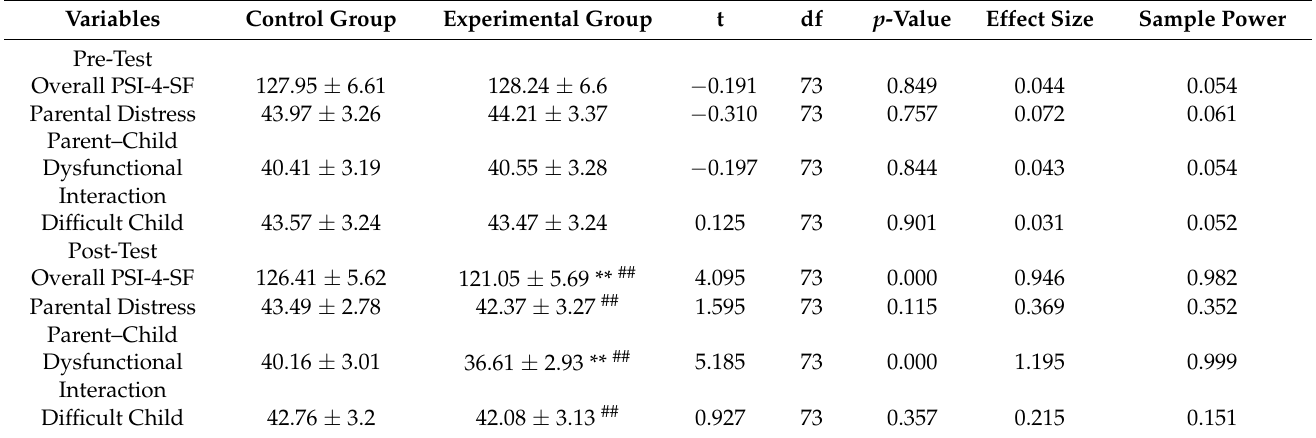
Table 7. Comparison of PSI-4-SF across two intervals between two groups.